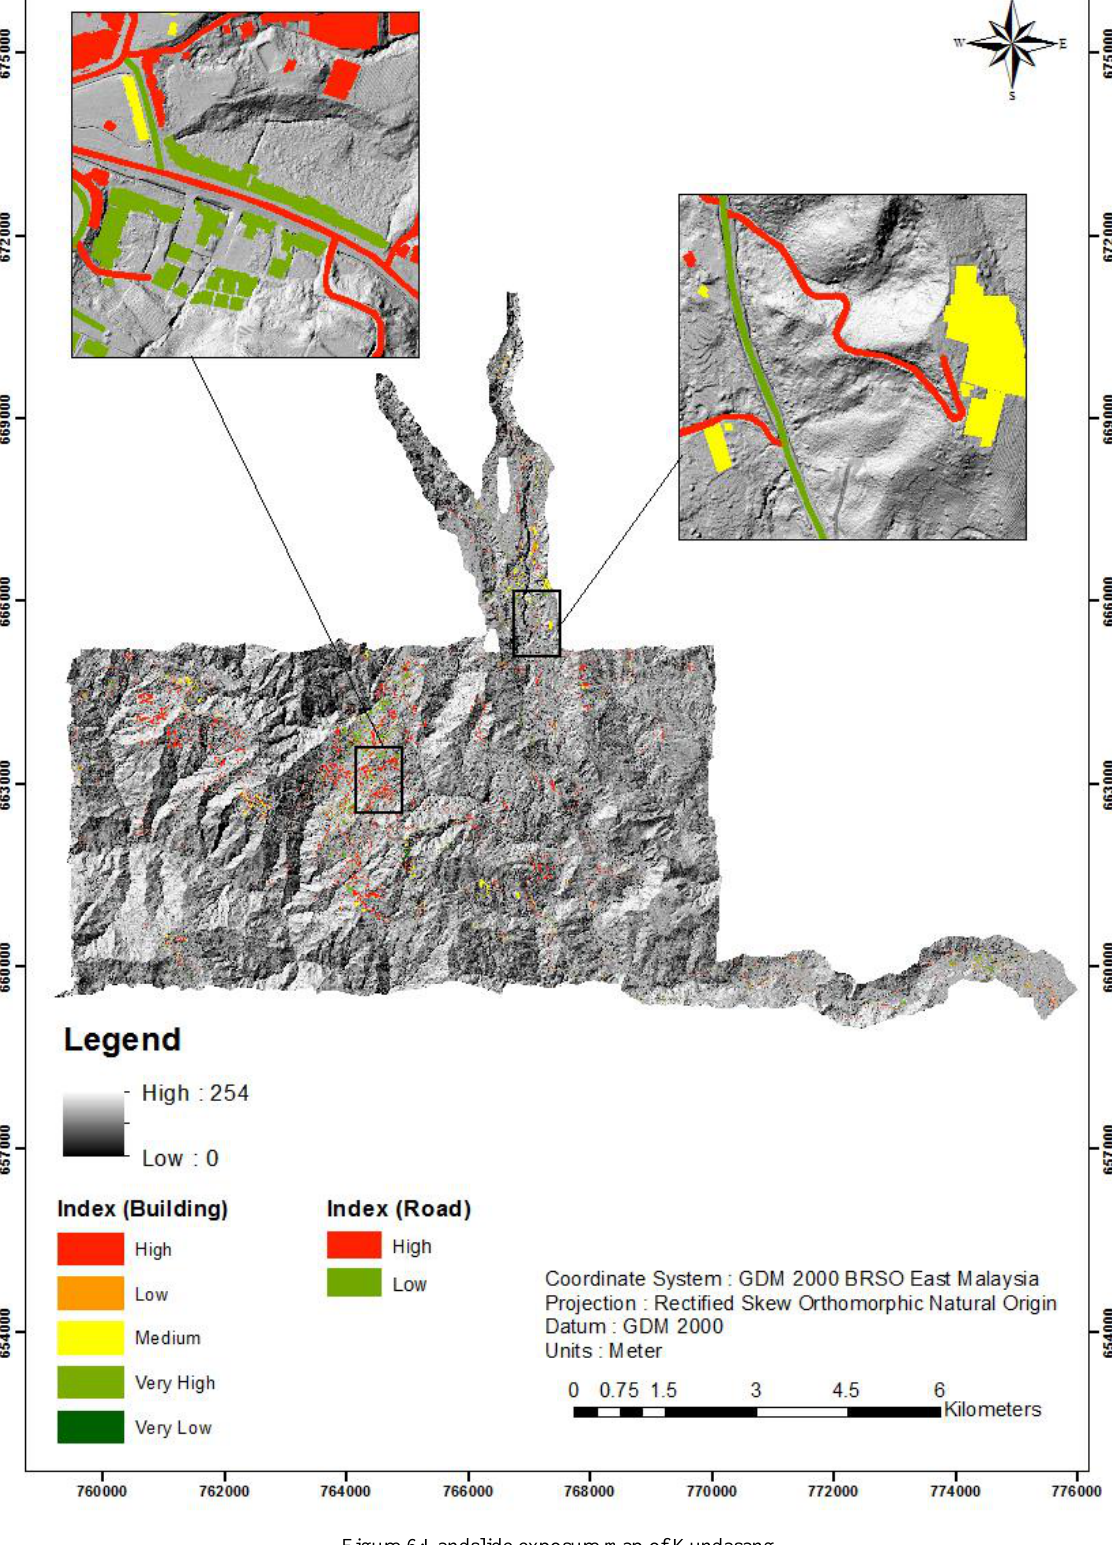
Figure 6:Landslide exposure map of